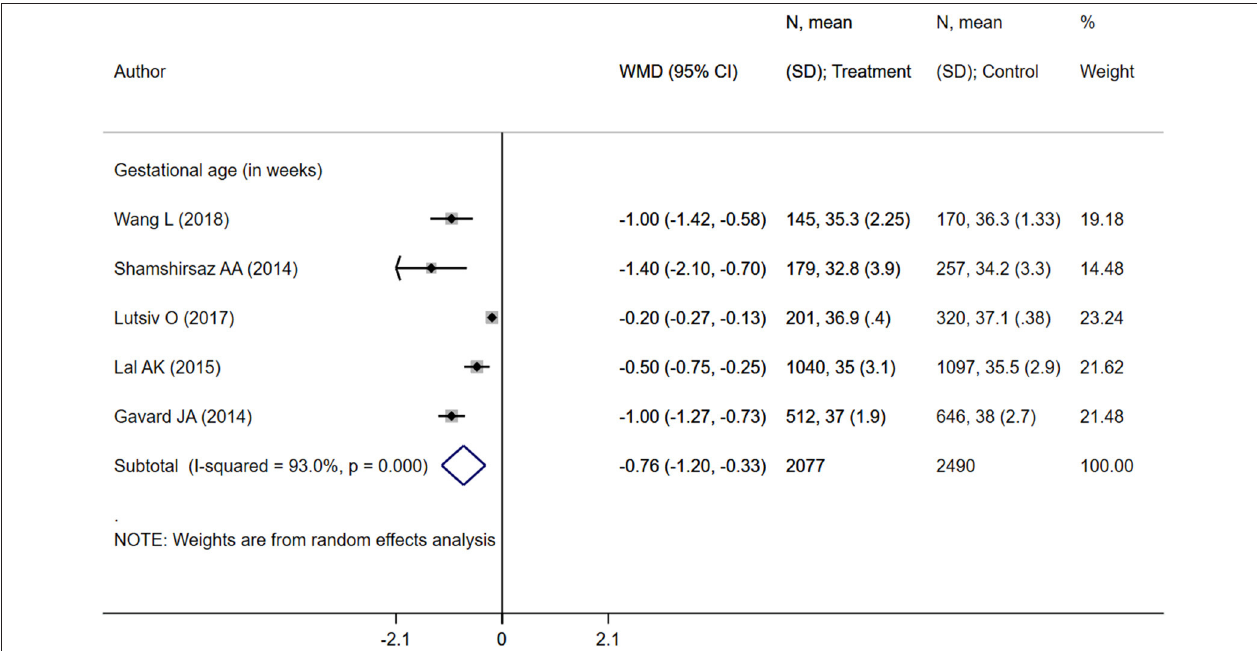
FIGURE 4 | Pooled analysis of inadequate or adequate pregnancy weight gain effects on gestational age.